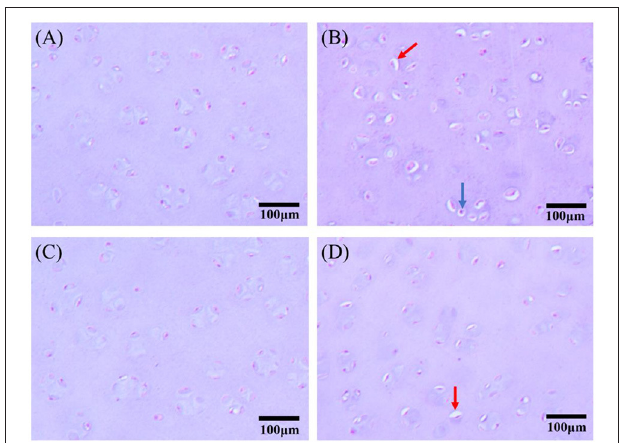
FIGURE 1 | Hematoxylin and eosin (HE) staining of chondrocytes in the femoral head articular cartilage (scale bar: 100 µ m). (A) Control group: Chondrocytes showed typical features in normal broilers. (B) MP group: There was obvious vacuole in the cytoplasm of chondrocyte, the nucleus of which was twisted and squeezed out to the cell edge (red arrow), and karyopyknosis could be observed in some of the chondrocytes (blue arrow). (C) 3-MA group: No obvious pathological changes. (D) 3-MA + MP group: Vacuoles were observed in fewer chondrocytes compared with MP group (red arrow).